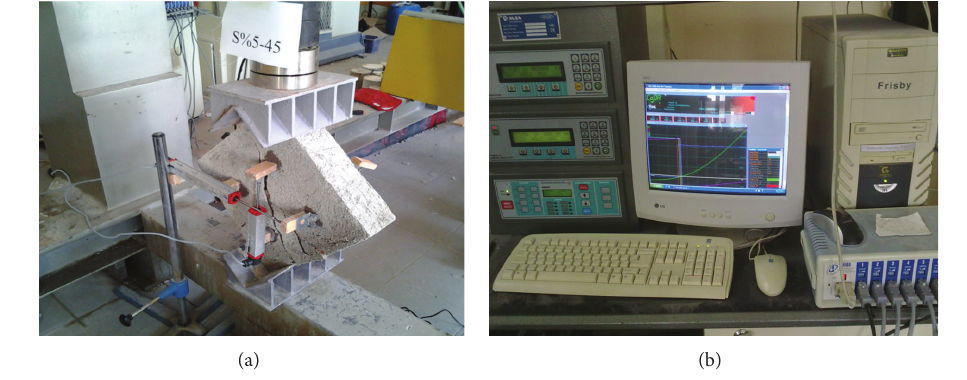
Figure 9: The experiment setup and data collection system. Table 2: The maximum load values and the load capacity of the walls.